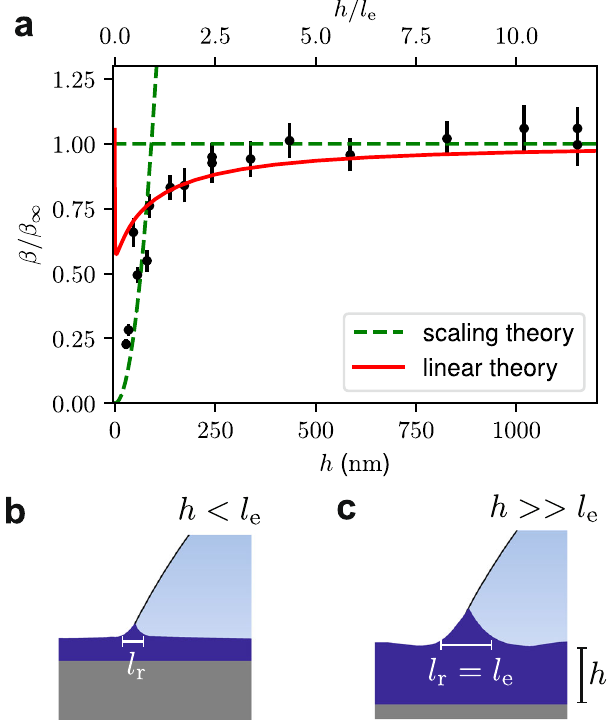
Fig. 4 | Substrate thickness effect on dissipation. a Plot of β , the dimensionless dissipation parameter, normalized by the bulk dissipation parameter, β ∞ , as a function of the softsubstrate layerthickness.The dashed lines correspondsto a fi t of the scaling model in the thin fi lm and thick fi lm regimes, while the solid line corresponds to the lineartheory. Errorbars arecalculated from the standard error of fi ttoequation(3)ofeachexperimentalrun. b and c illustratethetwoextremesof the scaling theory for a thin substrate fi lm, where the rigid underlying Si substrate contributes to the effective stiffness of the substrate, and the case of a thick sub- strate where the surface tension induced deformation is much smaller than the thickness of the fi